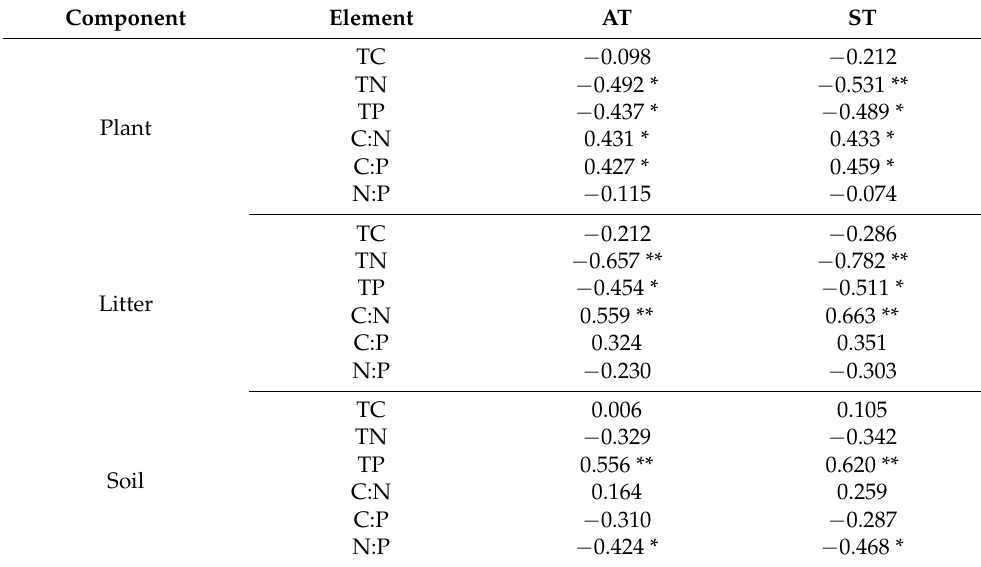
Table A2. Correlations between air, soil temperature and leaf, litter and soil N and P concentrations and